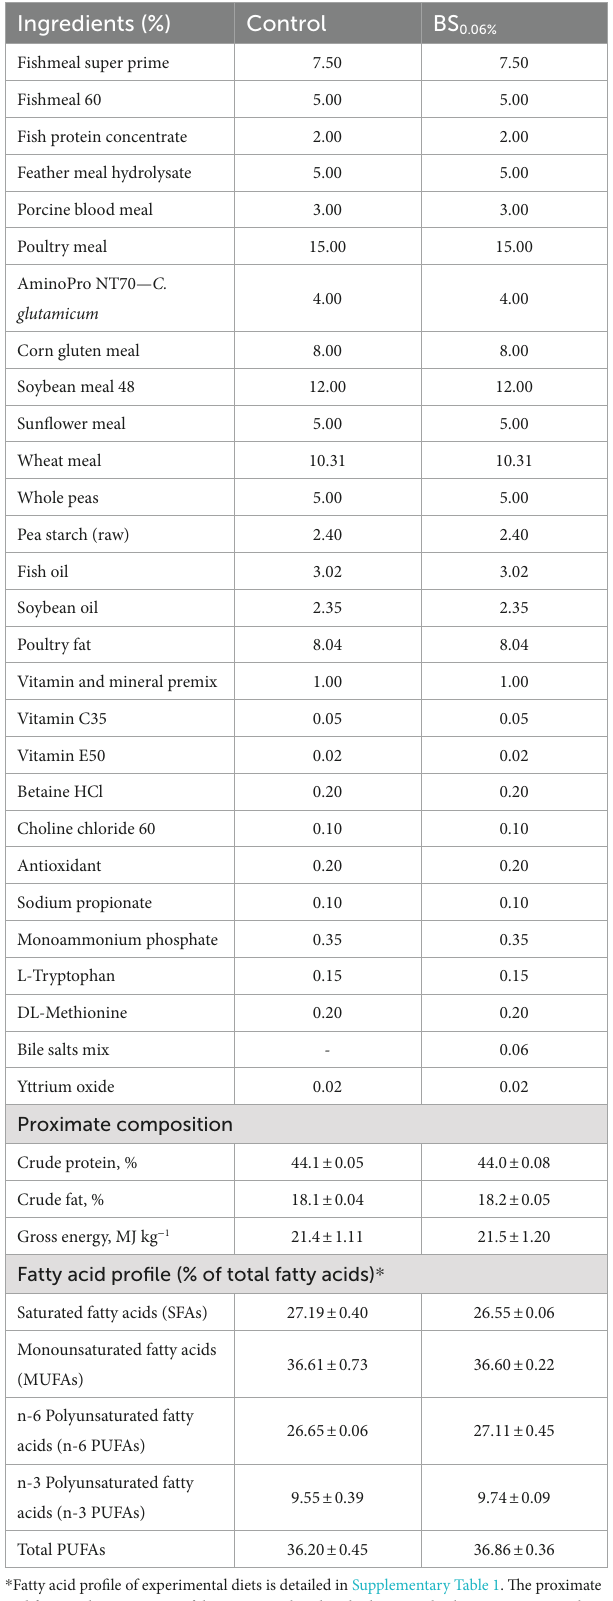
TABLE 1 Formulation, proximate composition (in dry form) and fatty acid profile of the control diet and the basal diet supplemented with a blend of bile salts (BSs) at a dietary inclusion of 0.06% (BS 0.06% ). Ingredients